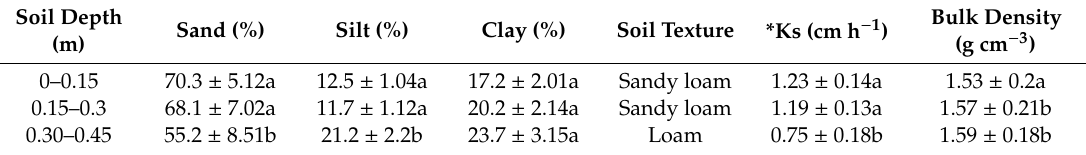
Table 1. Physical properties of soil.